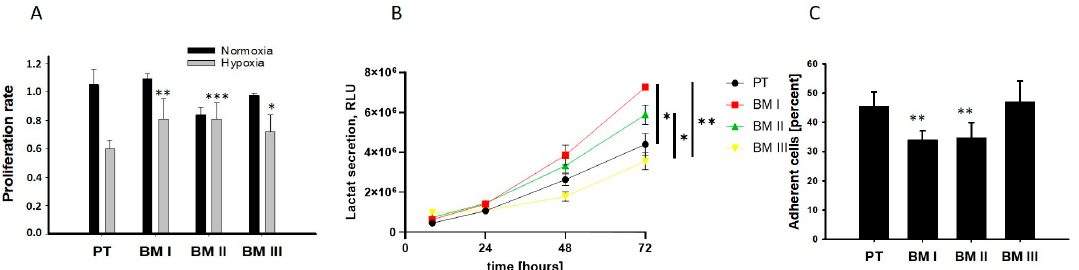
Figure 4. ( A ) The cells were cultivated under normoxia (20% O 2 ), or hypoxia (2% O 2 ), and 24 h after seeding, they were treated with BrdU. BrdU incorporation was assessed after further 24 h and 48 h of incubation. To calculate the proliferation rate, values obtained for cells incubated with BrdU for 48 h were normalized to those incubated for 24 h. ( B ) Lactate levels were analyzed in the medium of cells cultivated under normoxia after 12 h, 24 h, 48 h, and 72 h of incubation, using a luminescence-based assay. Luminescence is expressed as RLU. ( C ) The cells were seeded on collagen I-coated Petri dishes, and 4 h after incubation under normoxia, the number of adherent cells was counted. Shown are mean ± SEM of three independent experiments. * p < 0.05, ** p < 0.001, *** p <